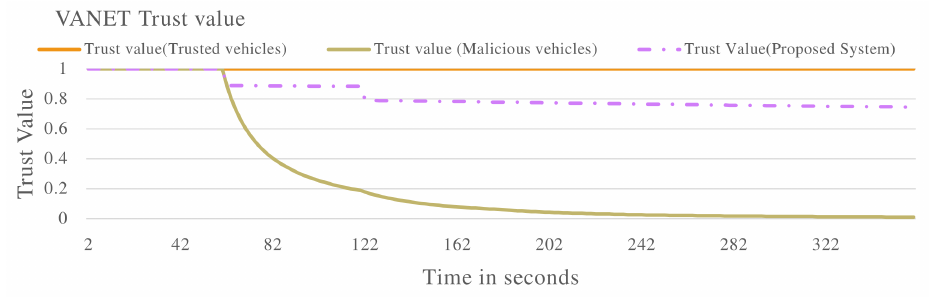
Figure 4. VANET trust value in multiple scenarios including malicious vehicles that are dropping packets in the VANET.